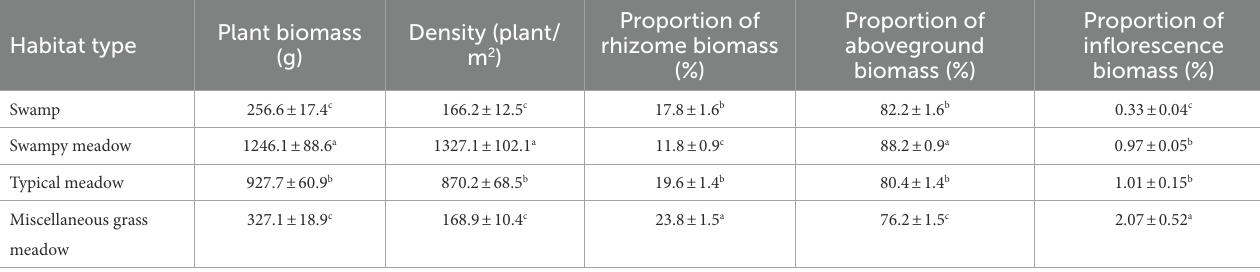
TABLE 2 Population characteristics of Deyeuxia angustifolia per unit area in four habitats. Habitat type